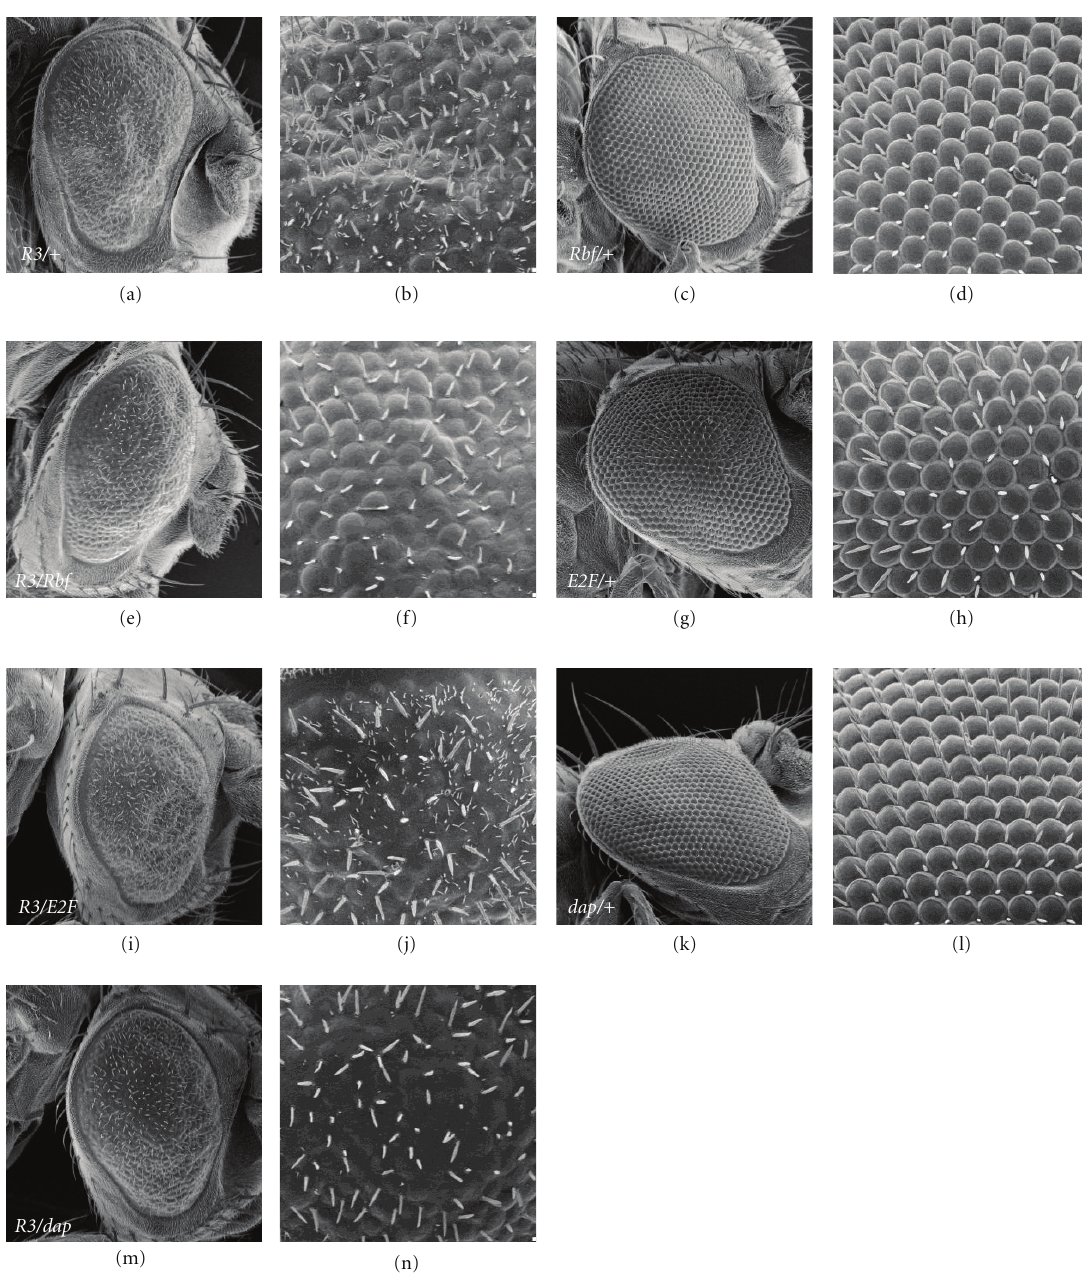
Figure 7: The GMR-R phenotype is suppressed by Drosophila Rb and p21 and enhanced by E2F. Crosses were performed between GMR-R3 and GMR-Rbf, GMR-E2F , and GMR-dacapo . SEMs, at 500x and 2000x, are shown for GMR-R3/+ (a, b), GMR-Rbf/+ (c, d), GMR-R3/GMR- Rbf (e, f), GMR-E2F/+ (g, h), GMR-R3/GMR-E2F (i, j), GMR-dacapo/+ (k, l), and GMR-R3/GMR-dacapo (m,